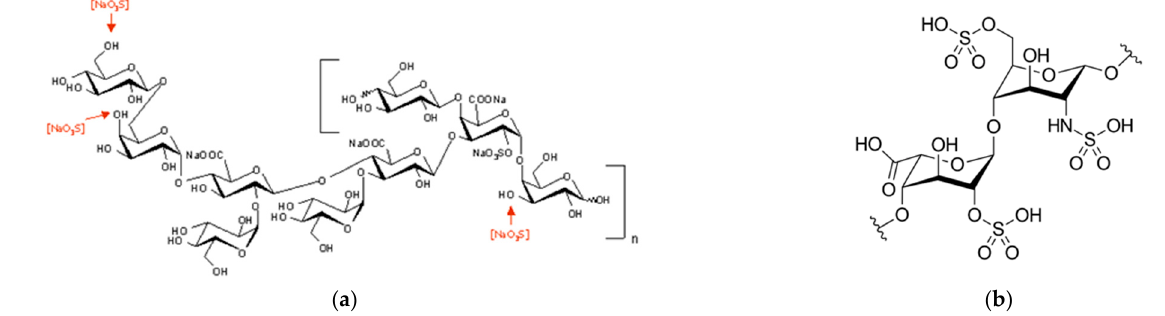
Figure 1. ( a ) Structure of EPS and postulated sulfated position after oversulfation reaction [12]. ( b ) Structure of heparin: the major repeating unit is the tri-sulfated disaccharide 2-O-sulfo- α -L-iduronic acid 1”4 linked to 6-O-sulfo-N-sulfo- α -D-glucosamine.